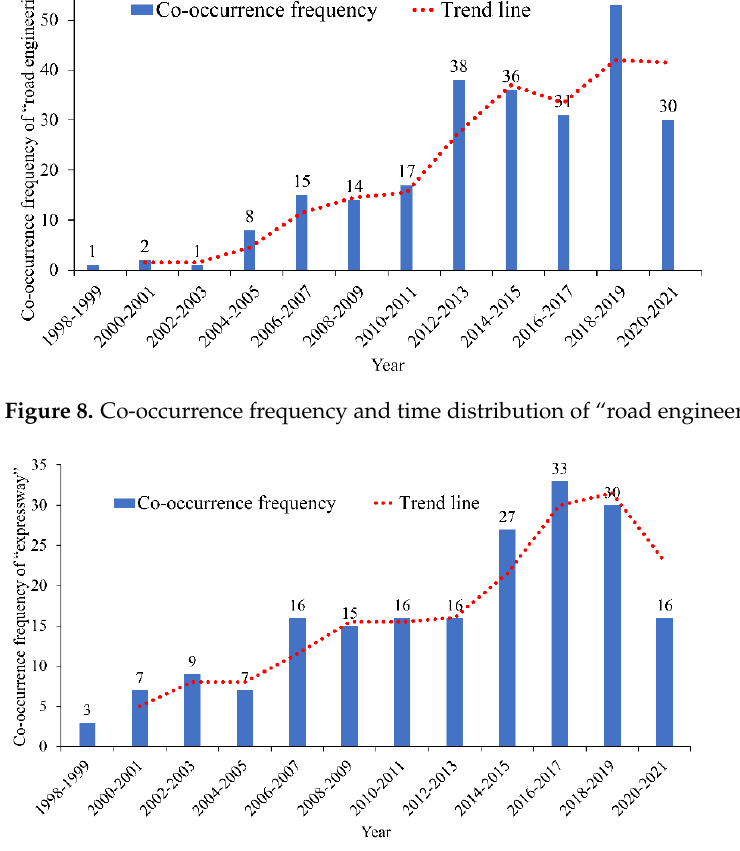
Figure 9. Co-occurrence frequency and time distribution of “expressway”.